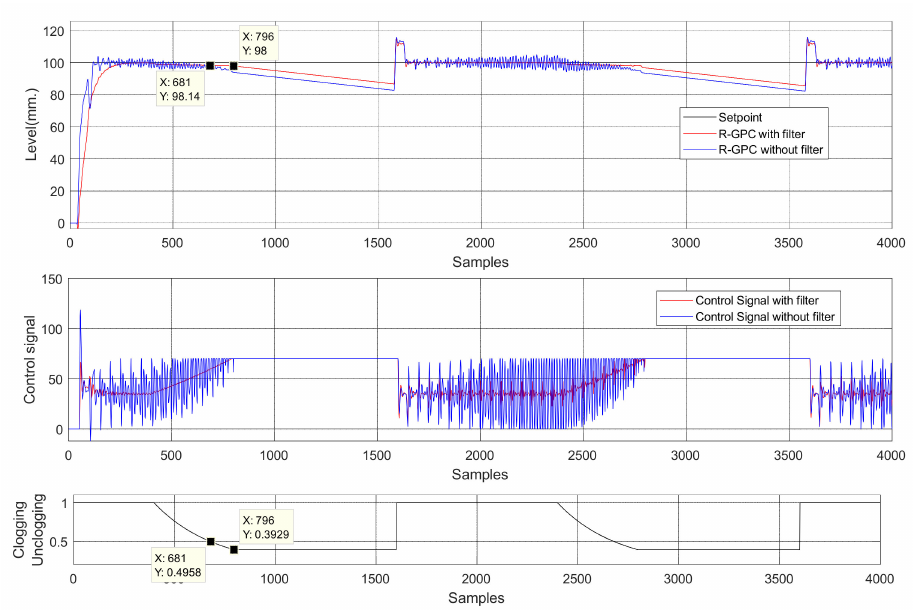
Figure 17. Comparison among the repetitive structures with filter (red), without filter (blue), and with the maximum